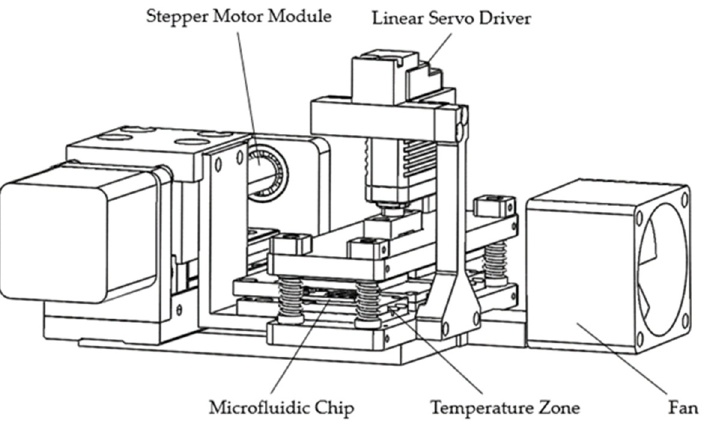
Figure 3. Three-dimensional